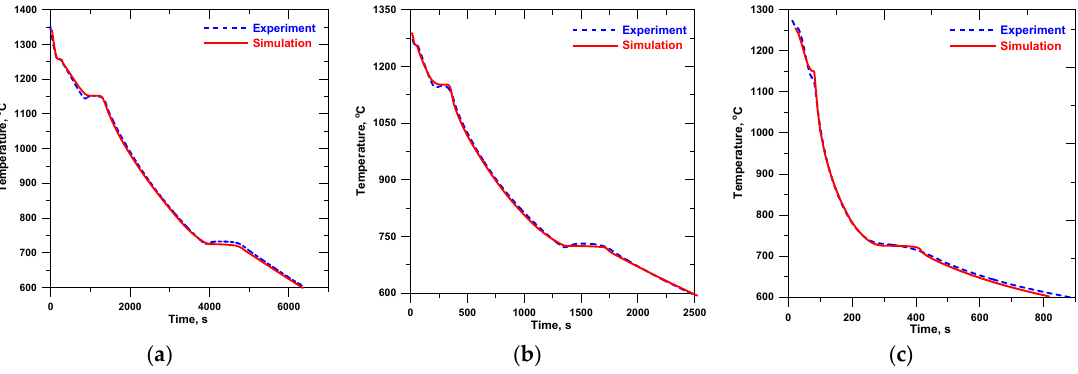
Figure 9. Simulated and experimental cooling curves (central thermocouple) for alloy D: ( a ) insulation ( b ) sand, and ( c ) chill.